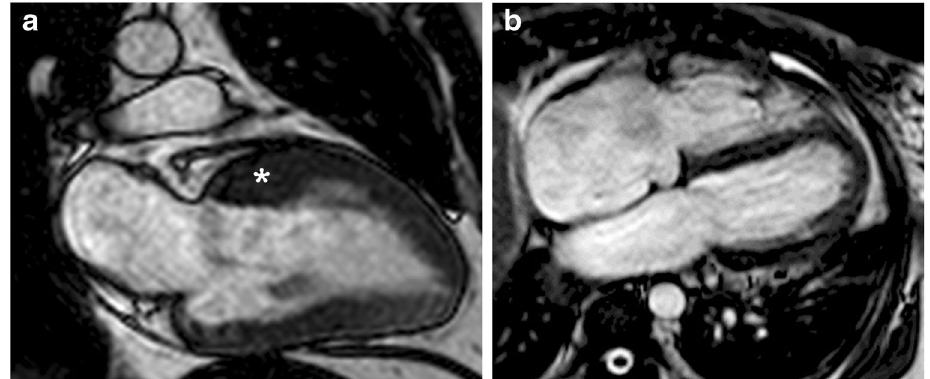
Fig. 13 End stage HCM with restrictive pattern. 77-year-old man who presented with several months of intermittent exertional dyspnea and asymmetric HCM. He presented to the emergency room7 years later with markedly worsening dyspnea and decompensated heart failure. a Two- chamber SSFP cine MR image performed at initial diagnosis shows